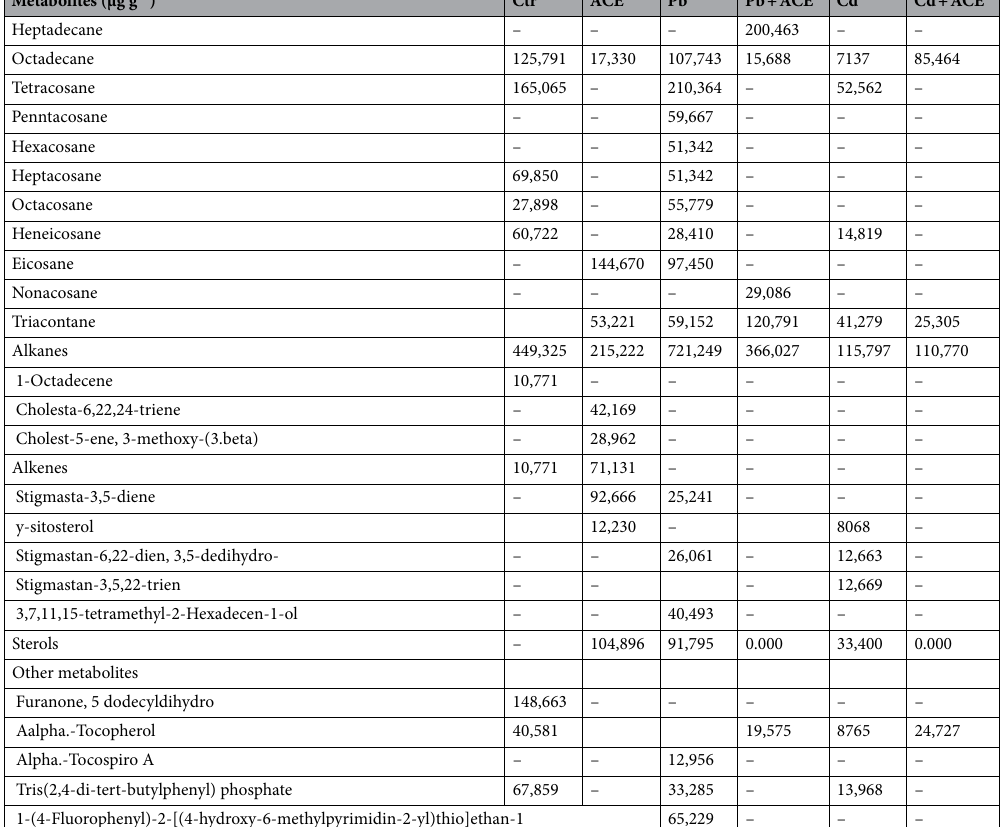
Table 2. Effect of ACE on alkanes, alkenes, and Sterols changes under Pb and Cd